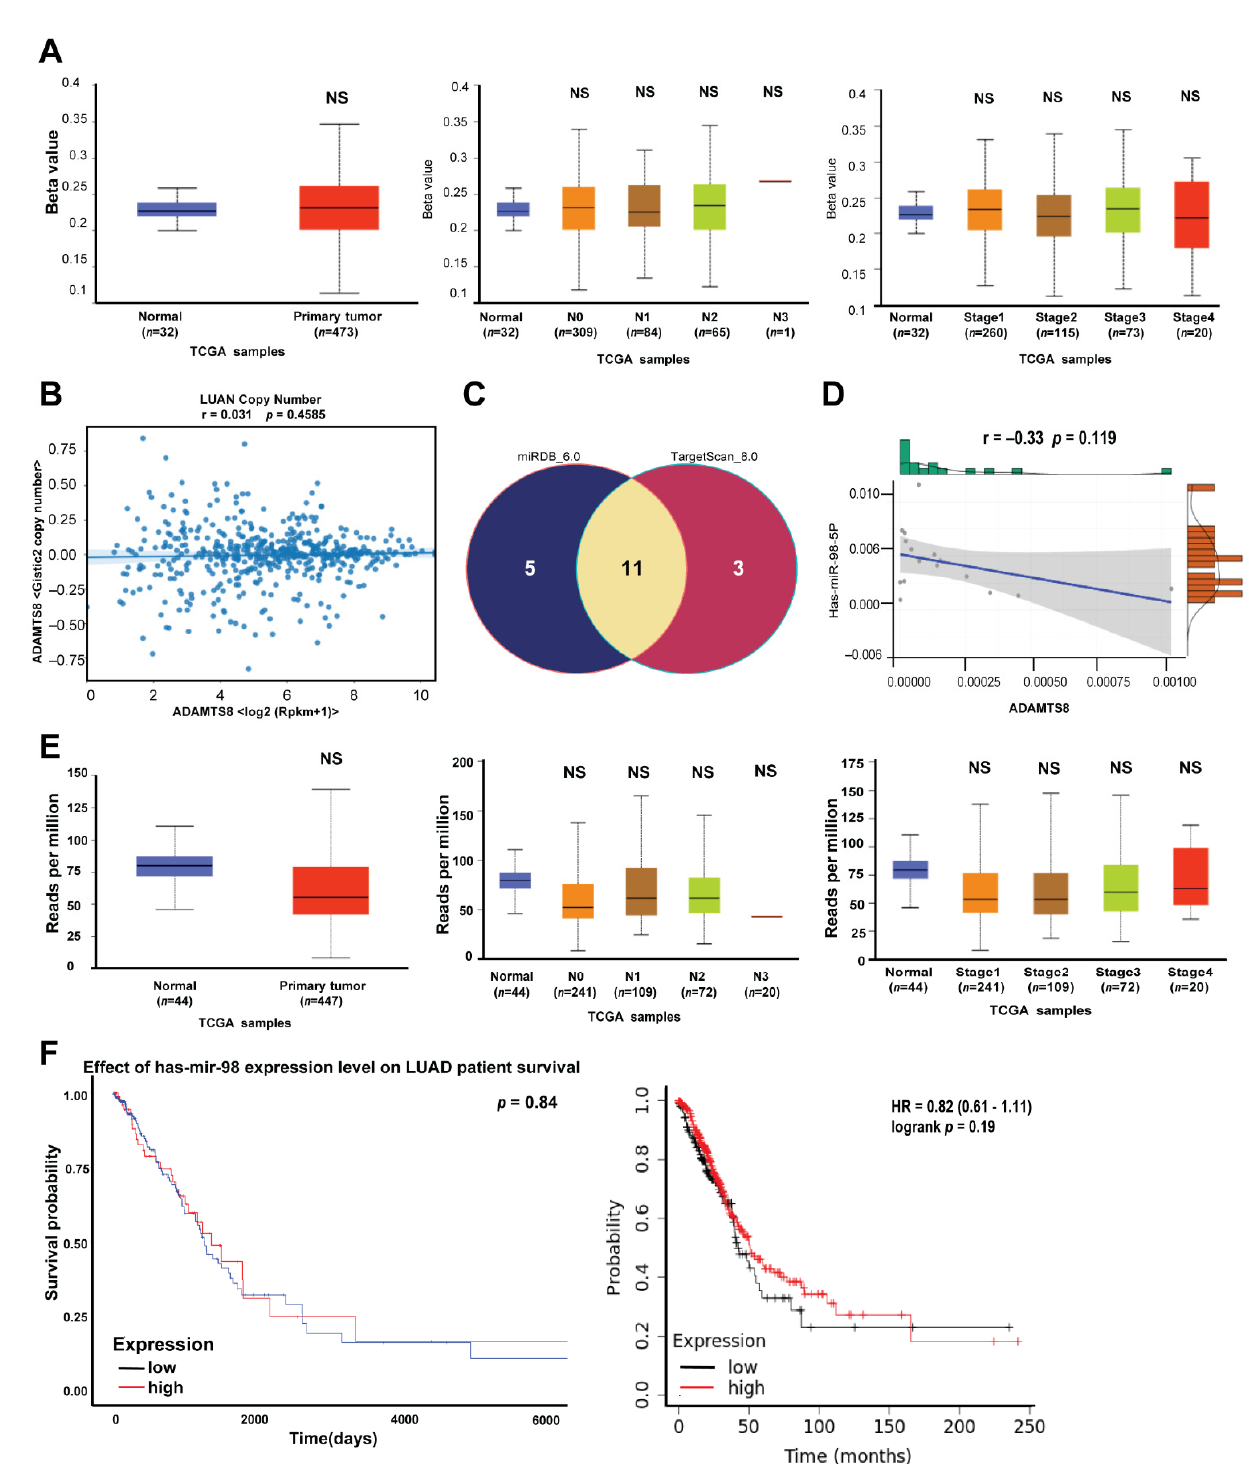
Figure 4. The possible regulatory factors affecting the expression of ADAMTS8. The levels of DNA methylation expressed in normal/tumor tissues (left panel, A ), lymph node metastasis (middle panel, A ) and tumor stage (right panel, A ). The correlation between ADAMTS8 mRNA expression and ADAMTS8 copy number variation ( B ). The predicted miRNAs from miRDB_6.0 and TargetScan_8.0 ( C ) and the correlation between miR-98-5p and ADAMTS8 ( D ). The expression levels of miR-98-5p between normal parts and tumor parts, in lymph node metastasis and tumor staging ( E ), and survival analysis ( F ) in lung cancer. NS, not